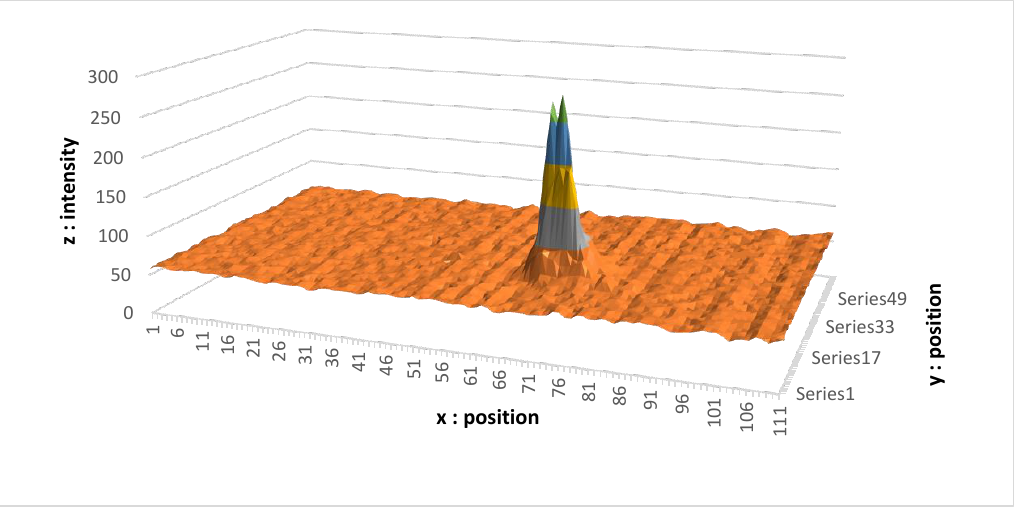
Figure 9. Signal obtained in poor luminosity.